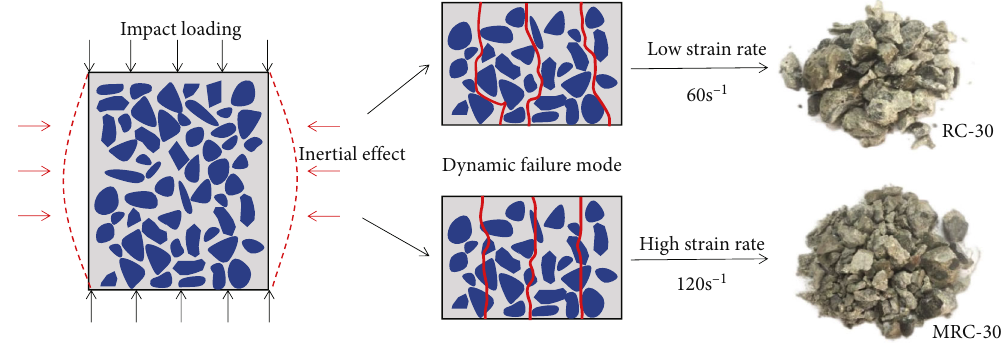
Figure 9: Dynamic failure